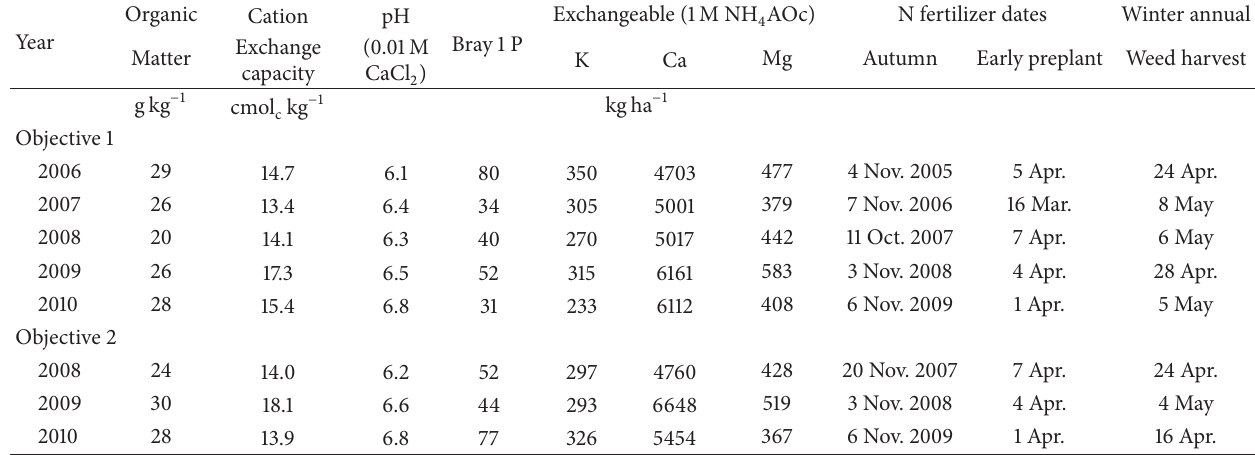
Table 1: Soil test values, nitrogen fertilizer application dates, and weed harvest dates prior to a burndown herbicide application for objectives 1 and